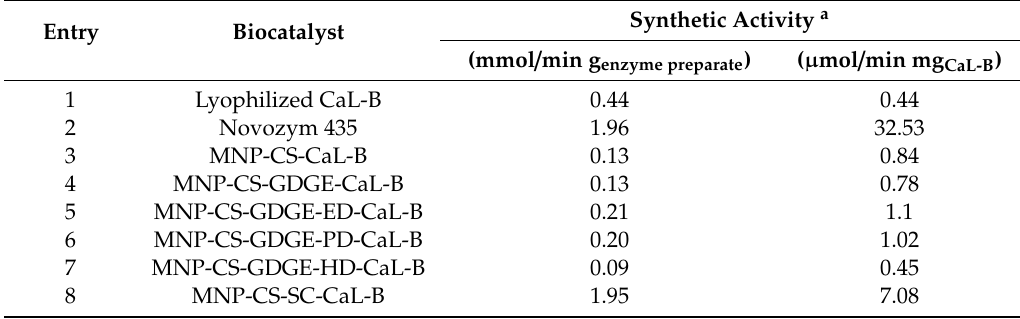
Table 1. The synthetic activity of the new obtained biocatalysts.